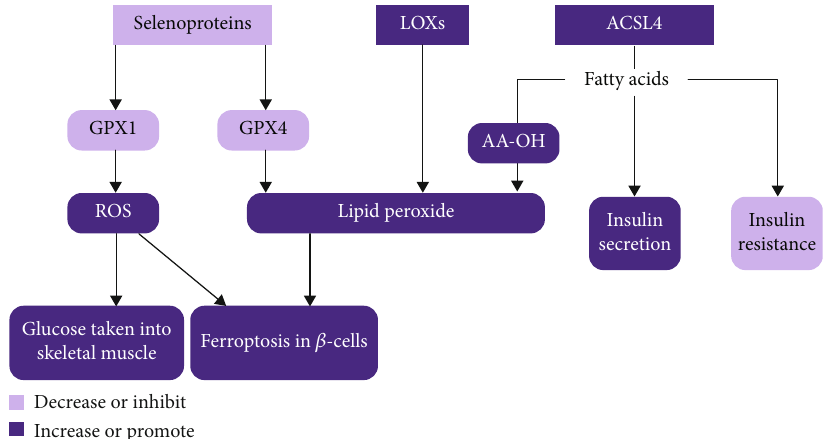
Figure 2: Selenoproteins, LOXs, and ACSL4 a ff ect pathogenesis of DM in di ff erent ways. GPX1 and GPX4 are both selenoproteins. A decrease in GPX1 or GPX4 causes accumulation of ROS and lipid peroxides in β -cells. Excessive ROS and lipid peroxides in turn induce ferroptosis in β -cells. ROS also promotes glucose intake into skeletal muscles. An increase in LOXs or ACSL4 produces excessive lipid peroxides and then ferroptosis in β -cells as well. Although ACSL4 can promote insulin secretion in β -cells, it aggravates peripheral insulin